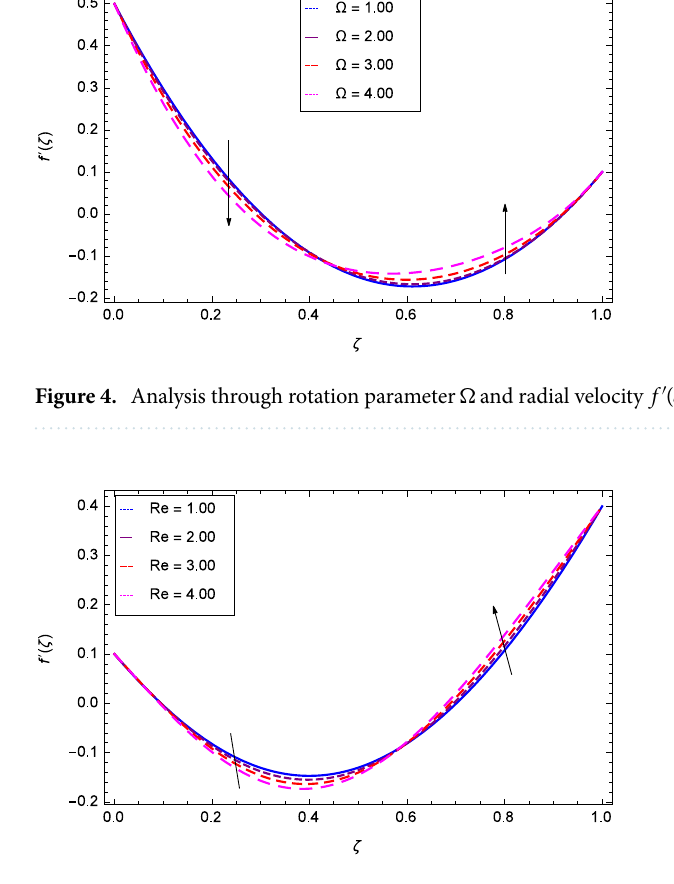
Figure 5. Analysis through Reynolds number Re and radial velocity f ′ ( ζ